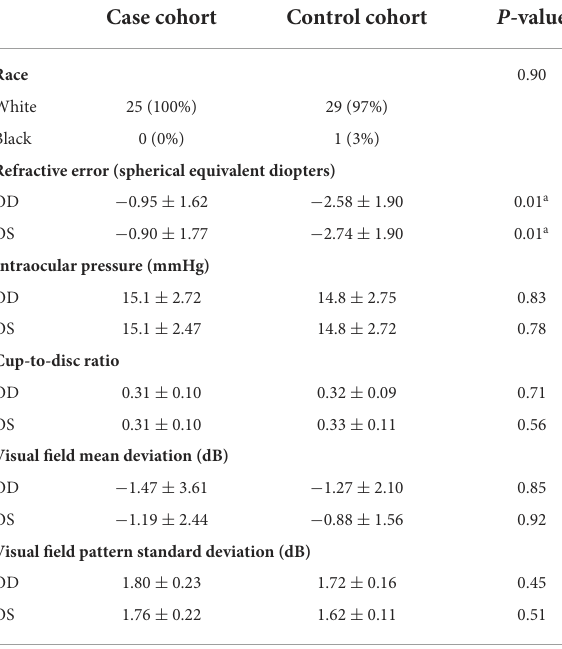
TABLE 1 Traumatic brain injury (TBI) history of case subjects. TABLE 2 Characteristics of all study